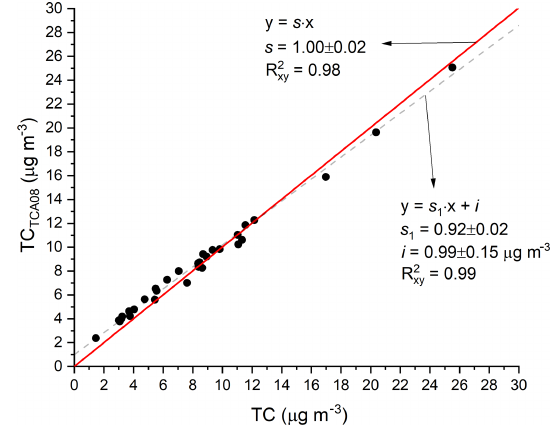
Figure 6. Comparison of offline measurements of TC (laboratory filter analyses) to the 24h average of 1h online measurements of TC from the TCA08. Linear orthogonal regression results are shown with s as the slope (red line) for the model without an intercept and with s 1 as the slope and i as the intercept (dashed gray line) for the model with an intercept. R 2 xy is the square of the Pearson correlation coefficient. A total of 31 samples were collected for analysis during the